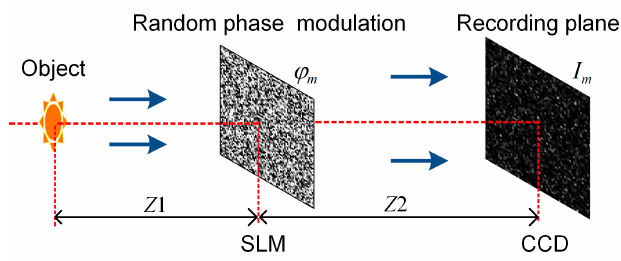
Figure1. Schematicoftheopticalset-up. ϕ m isthemodulatedrandomphase, and I m isthecorresponding recoded